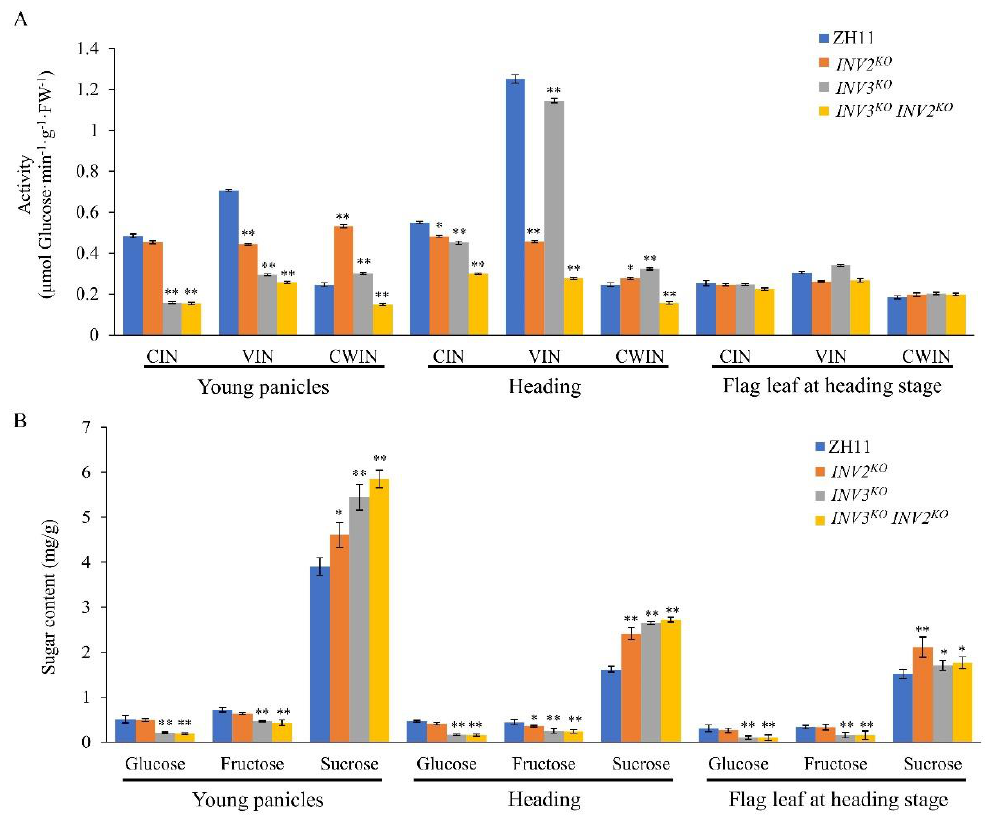
Figure 10. Comparisons of invertase activity and sugar content of ZH11, INV2 KO , INV3 KO and INV3 KO INV2 KO . Activities of three invertase isoforms (CIN, VIN, CWIN) ( A ) and sugar content ( B ) in young panicles, heading and flag leaf at heading stage of ZH11, INV2 KO , INV3 KO , and INV3 KO INV2 KO . Data are given as means ± SD. Student’s t-test was used to generate the p values; **, * indicate p < 0.01, p < 0.05, respectively.